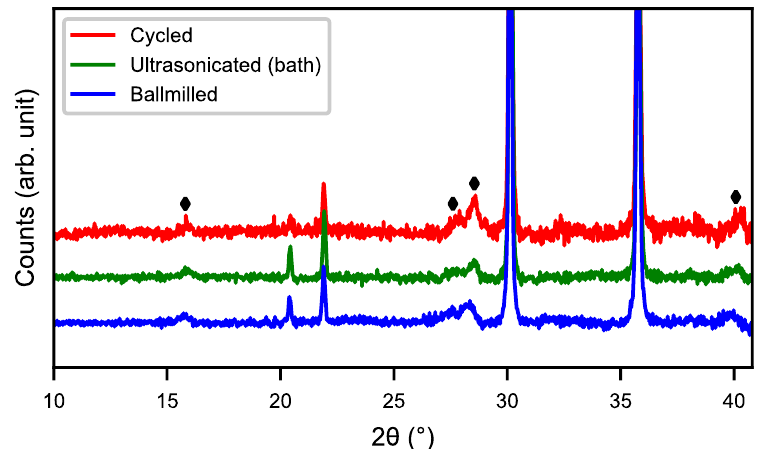
Figure 5. XRD patterns of cycled material, material from the ultrasonic bath, and ball-milled material, respectively. ( ) RE(OH) 3 .